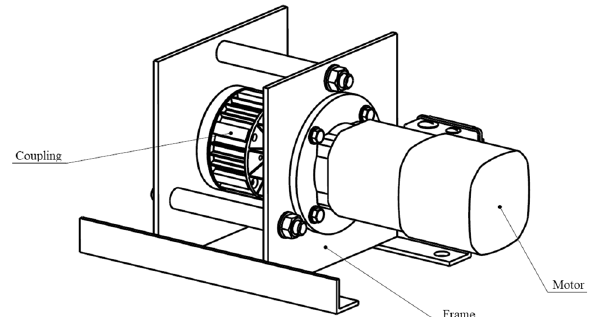
Fig. 8 Experimental